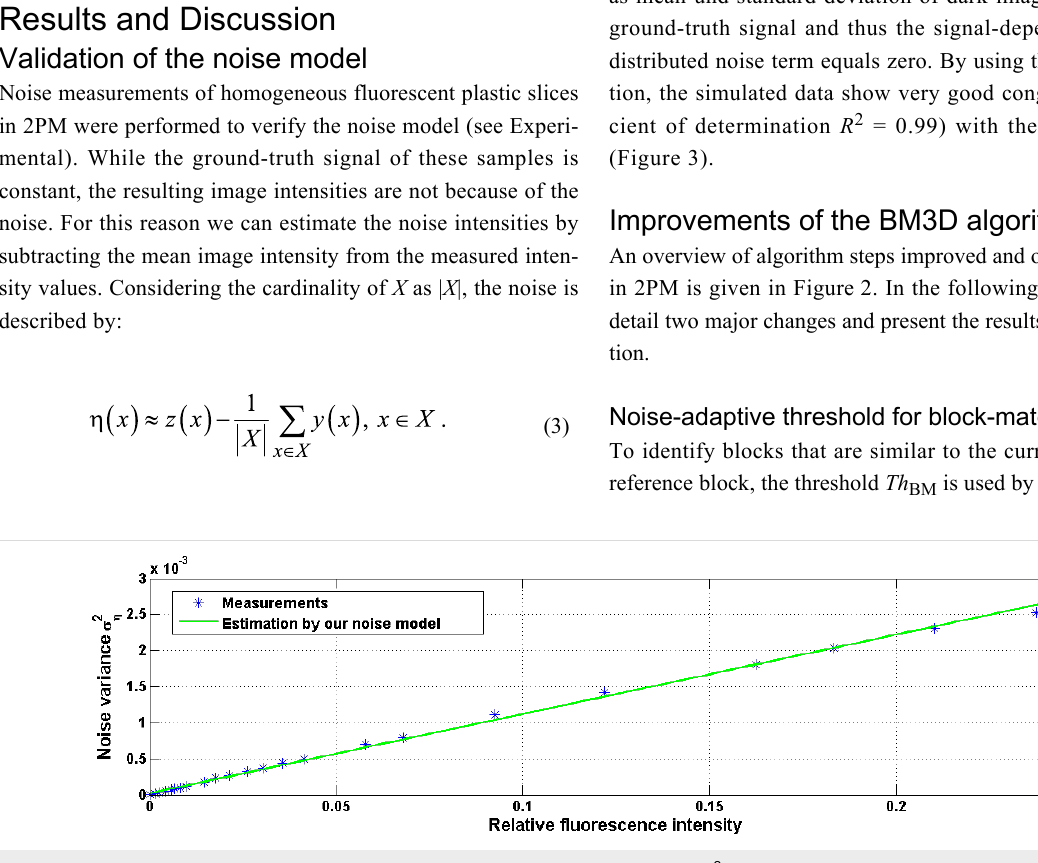
has to be used, in which η p ( x ) ~ P ( y ( x )) is a Poisson-distributed signal-dependent component, scaled by a constant α > 0 and η G ( x ) a Gaussian-distributed signal-independent component with mean μ G and variance σ G 2